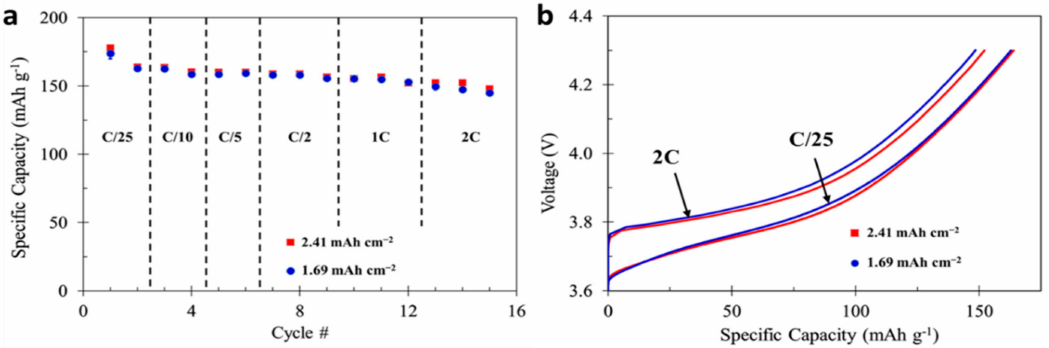
Figure 2. ( a ) Positive half-cell mean rate performance with range bars for NMC electrodes with 2.41 and 1.69 mAh cm − 2 areal capacity loading and ( b ) voltage profiles for positive half-cells at C/25 and 2C rates.